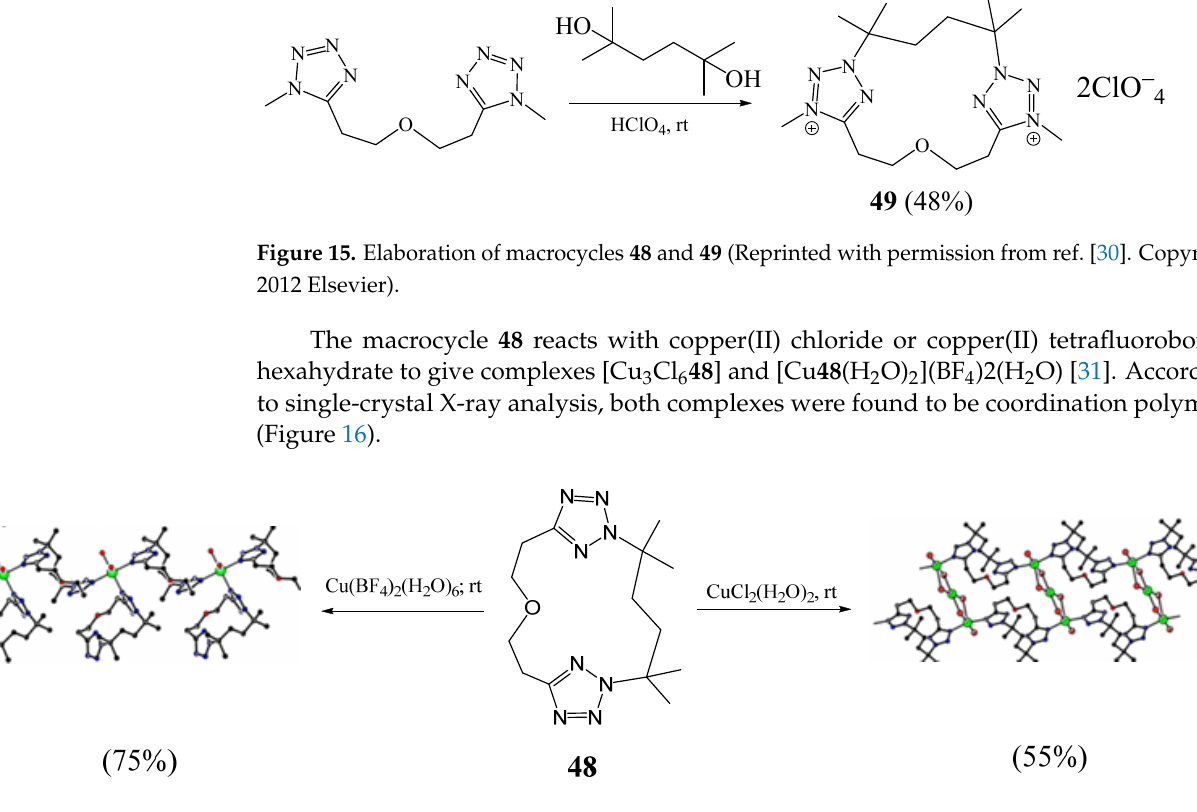
Figure 16. Copper complexes based on tetrazolic macrocycle 48. (Reprinted with permission from ref. [31]. Copyright 2017 American Chemical Societ).